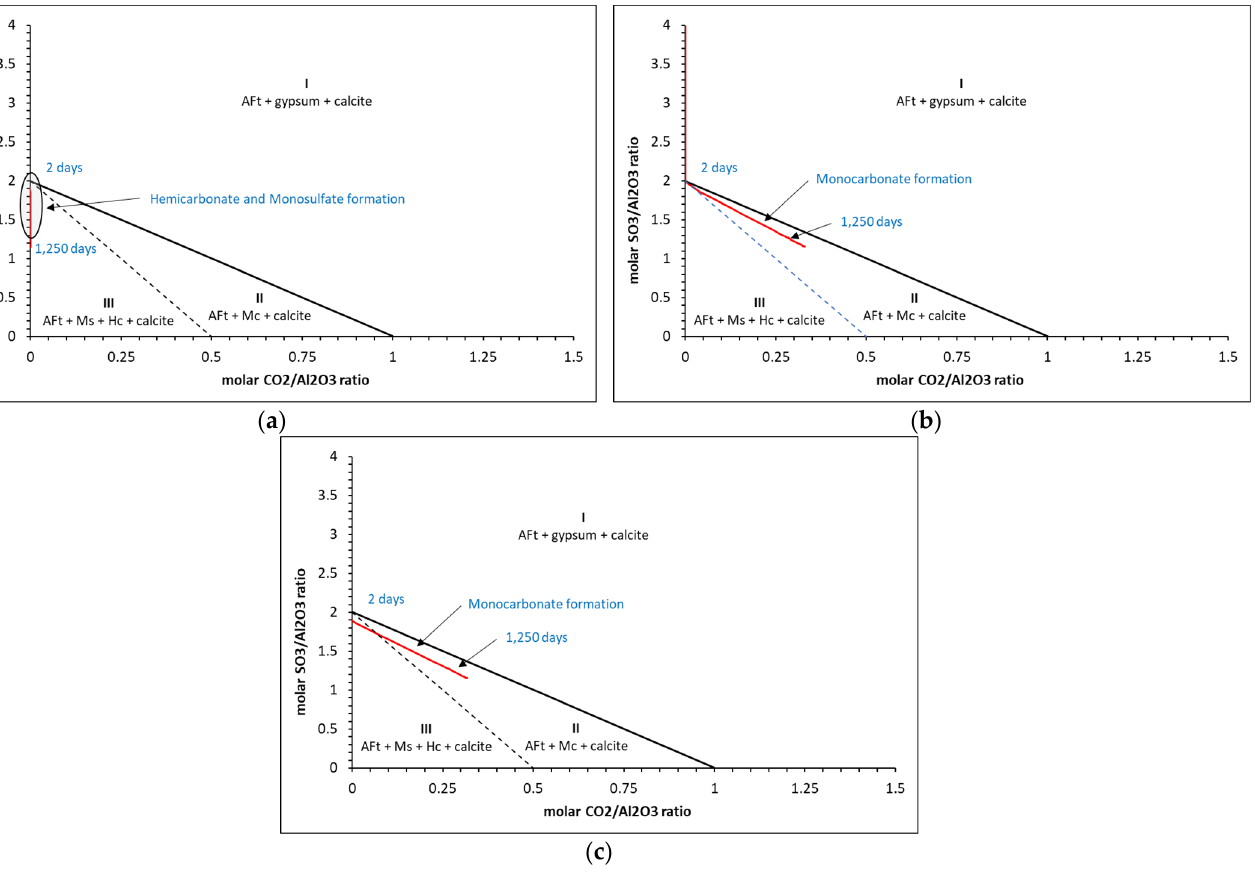
Figure 15. Thermodynamic predictions of carbonate and sulfate ratios for ( a ) 0%, ( b ) 2% and ( c ) 5% calcite for the w/c = 0.6 cement.